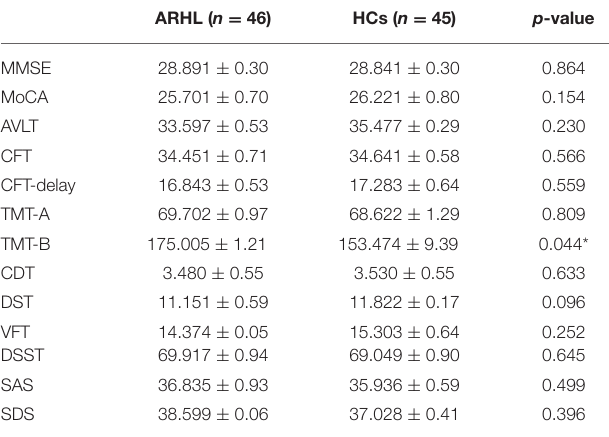
TABLE 2 | Neuropsychological scores of the ARHL and